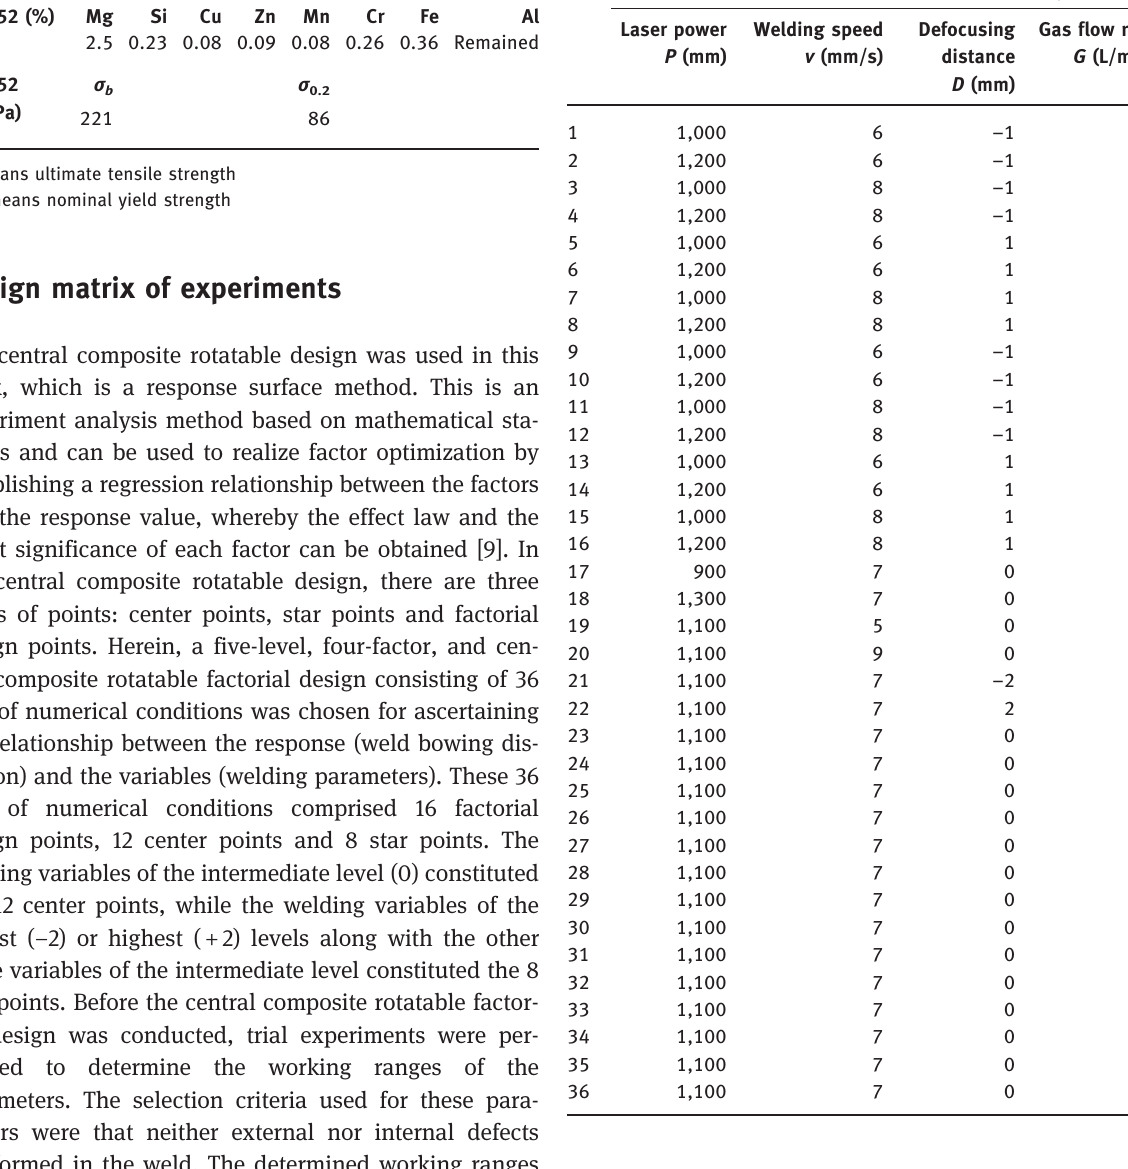
Table 2: Welding parameters and their levels used in this study.